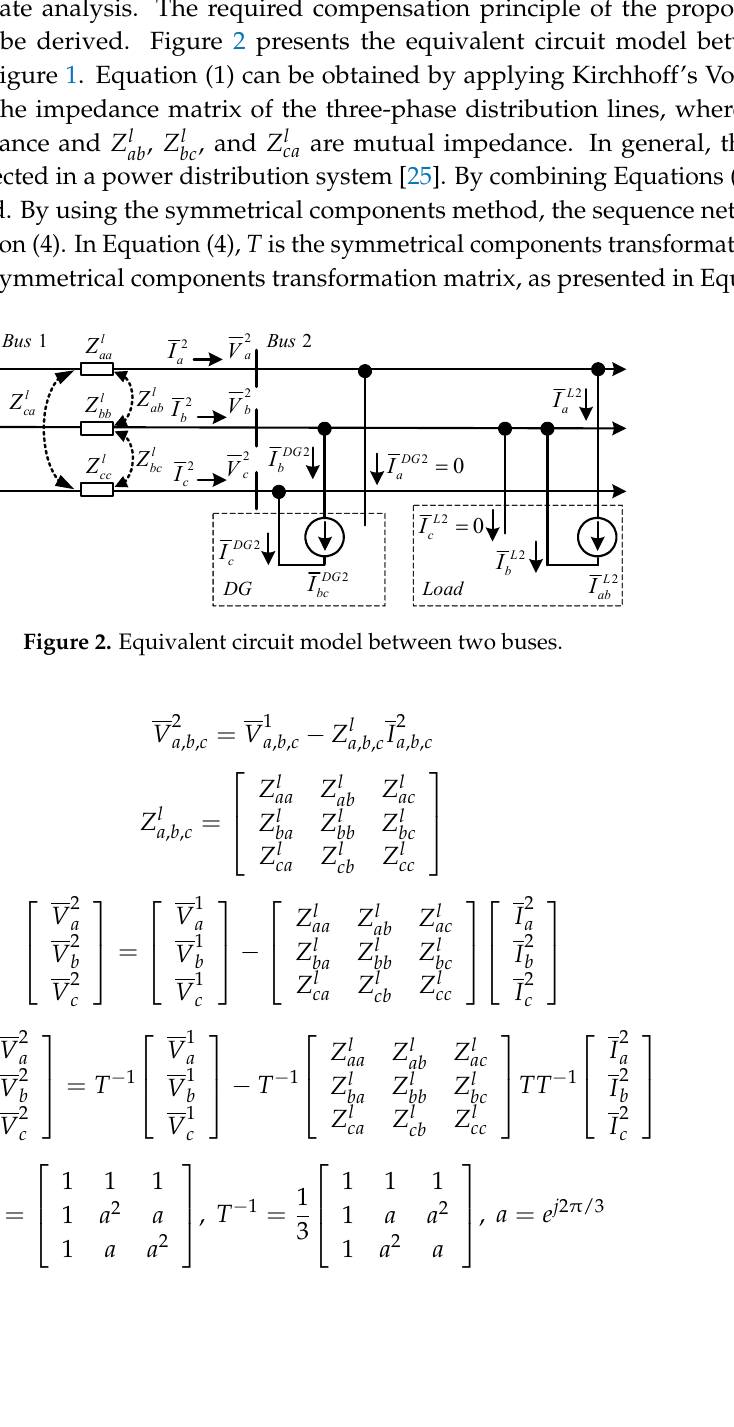
Figure 1. Radial-type, three-phase microgrid with unbalanced distributed generators (DGs) and loads.